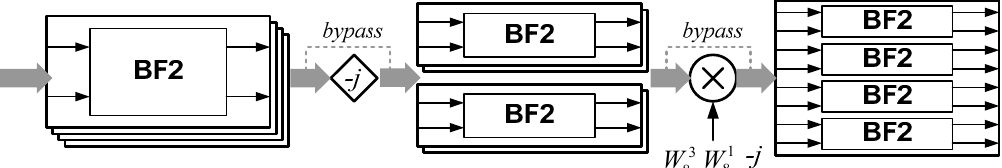
Figure 14. Block diagram of the first or second BF8 unit in Module 4.